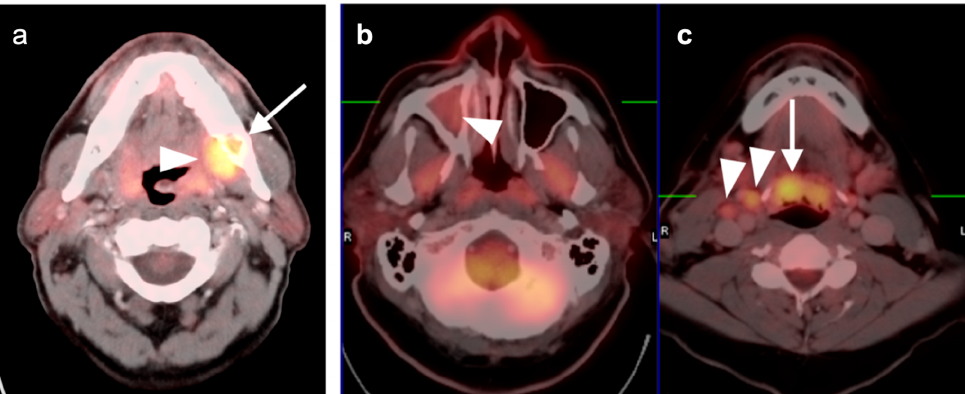
Figure 1. Inflammatory conditions of the head and neck that mimic tumor on FDG PET ‐ CT. ( a ) Periodontal abscess, shown by a hypermetabolic inflammatory mass (white arrowhead) on the lingual side of an erosive osseous lesion of a tooth socket (white arrow); ( b , c ) right maxillary sinusitis, likely chronic because of neo osteogenesis ( b , white arrowhead) with associated hypermetabolic lymphoid tissue in the base of the tongue ( c , white arrow) and prominent hypermetabolic right cervical lymph nodes ( c , white